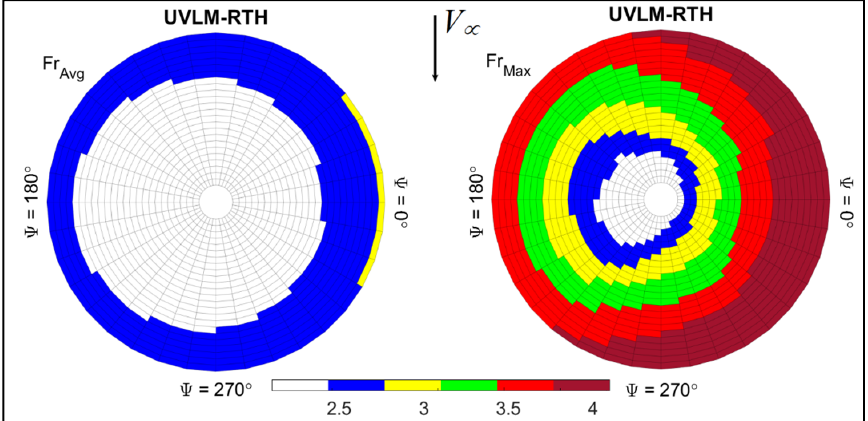
Figure 22. Contours of steady state Fr Avg and Fr Max for the modified Bell 429 tail rotor in forward flight obtained using BEMT-RHT and UVLM-RHT.